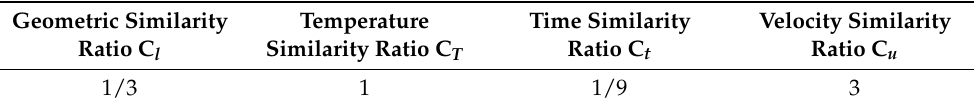
Table 2. Model similarity ratio.